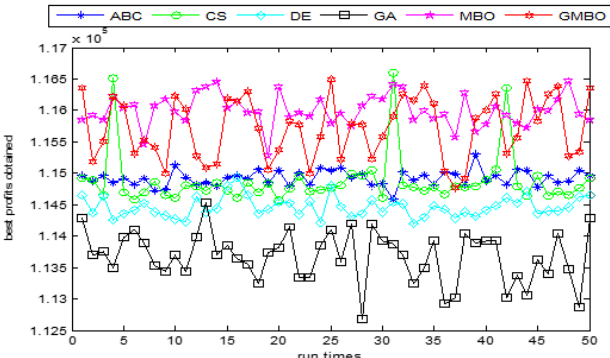
Figure 10. Comparison of the best values on KP10 in 50 runs.